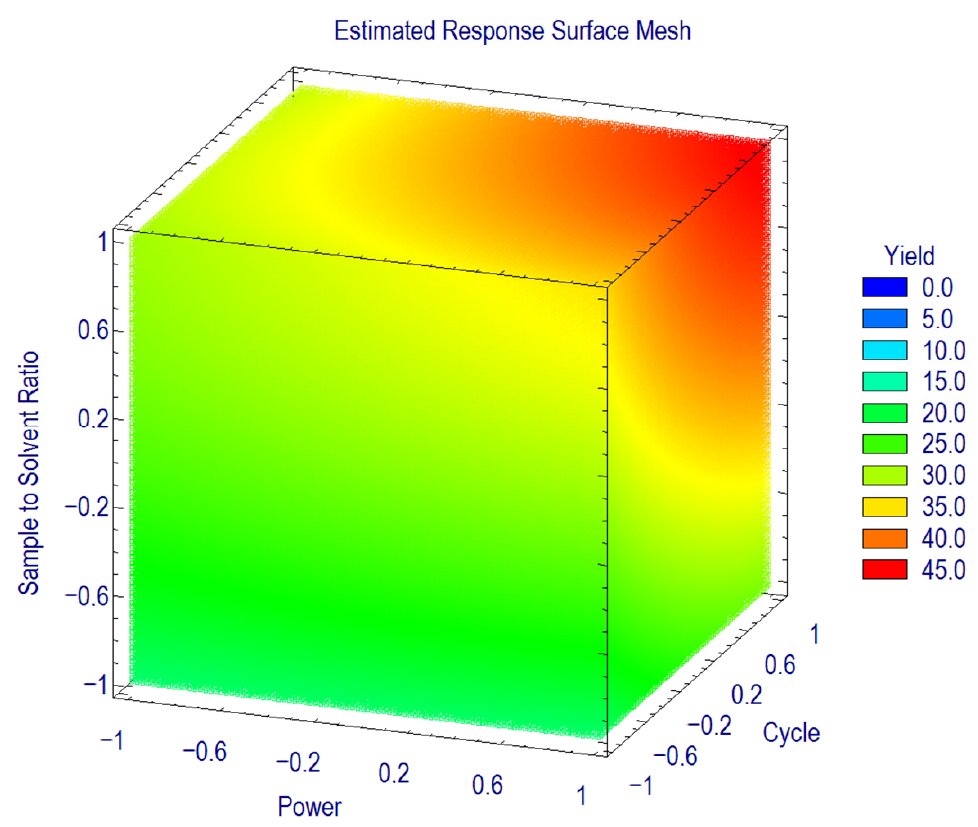
Figure 3. 3D estimated response surface mesh for the studied ultrasound-assisted extraction (UAE) factors.